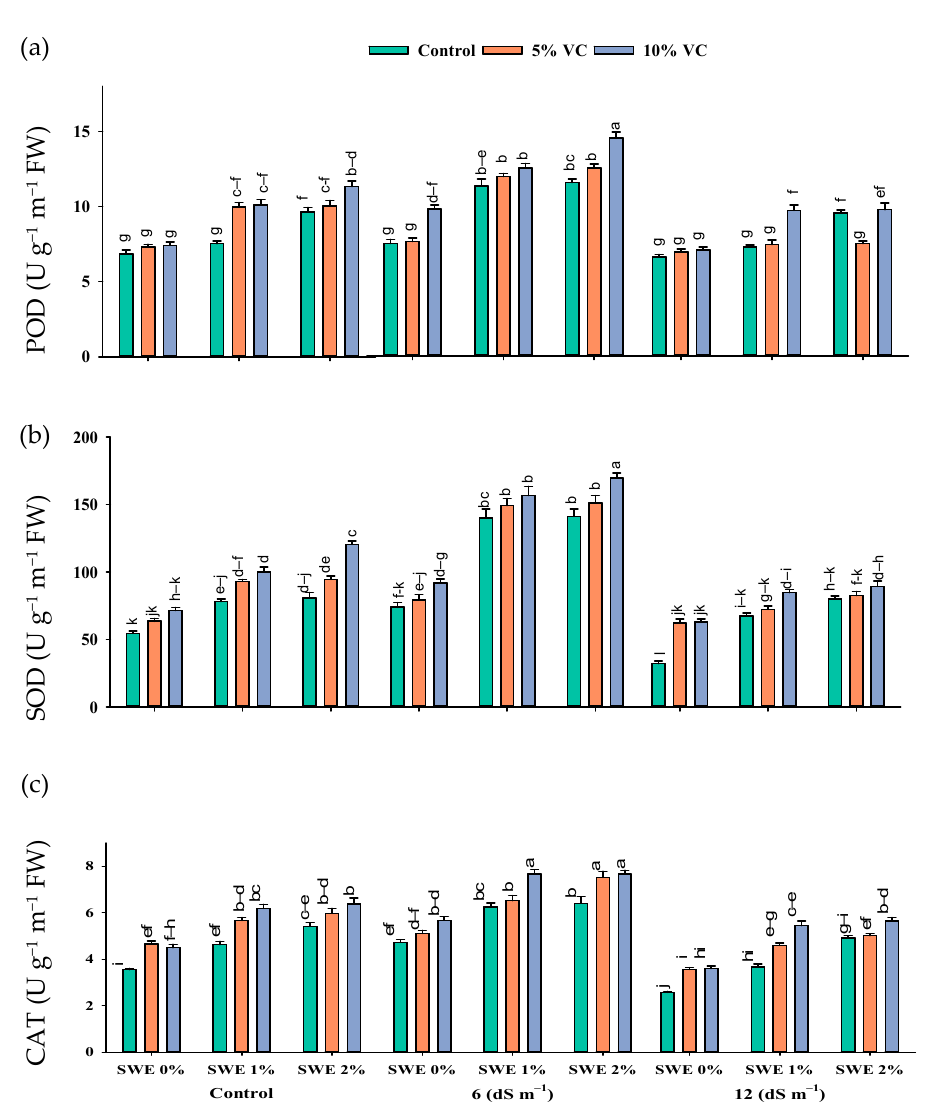
Figure 3. Activities of enzymatic antioxidants {POD ( a ), SOD ( b ), and CAT ( c )} in maize are affected by various treatments of vermicompost (VC), sorghum water extract (SWE) under control, moderate salinity (6 dS m − 1 ), and high salinity (12 dS m − 1 ). Error bars depict the standard error of 3 replications ( n = 3). Bars with the same letters do not differ significantly ( p ≤ 0.05).